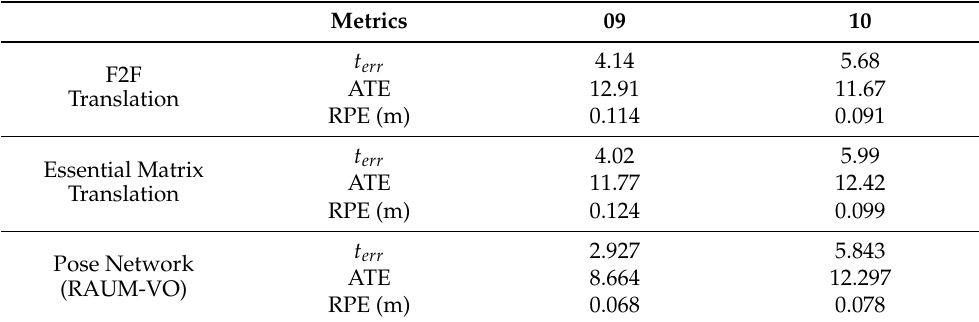
Table 5. Scale alignment. Results of the scale alignment procedure applied to the translation vector from the F2F and the essential matrix estimated